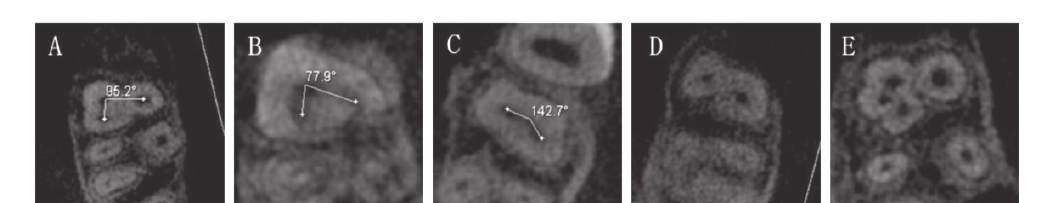
Figure 1- Images of transverse sections of the orifice in different cases. (A) Transverse sections with angle of 95.2°; (B) Transverse section with an angle of 77.9°; (C) Transverse sections with an angle of 142.7°; (D) Transverse section with